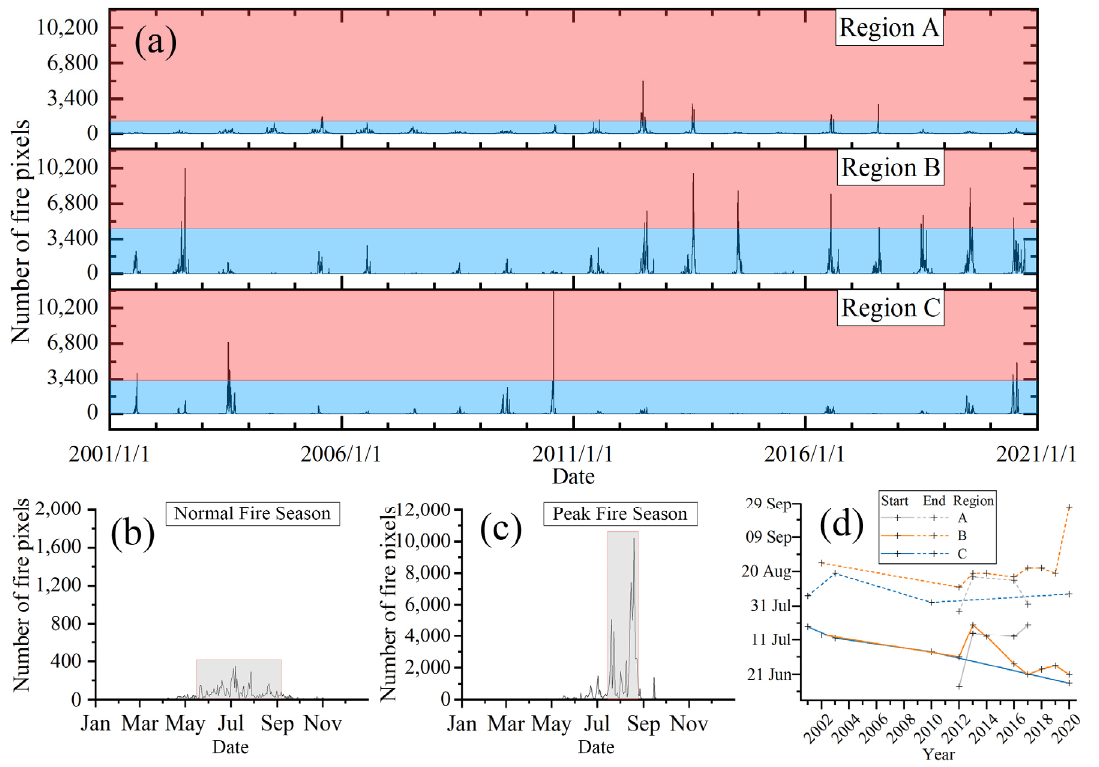
Figure 8. Fire seasons and associated terminology used in this paper. ( a ) Definition of “high fire incidence year”. ( b ) Example of “normal fire season” in region A and ( c ) “peak fire season” for region B, as indicated by the gray shading. ( d ) The start and end dates of peak fire seasons for high fire incidence years in three regions.